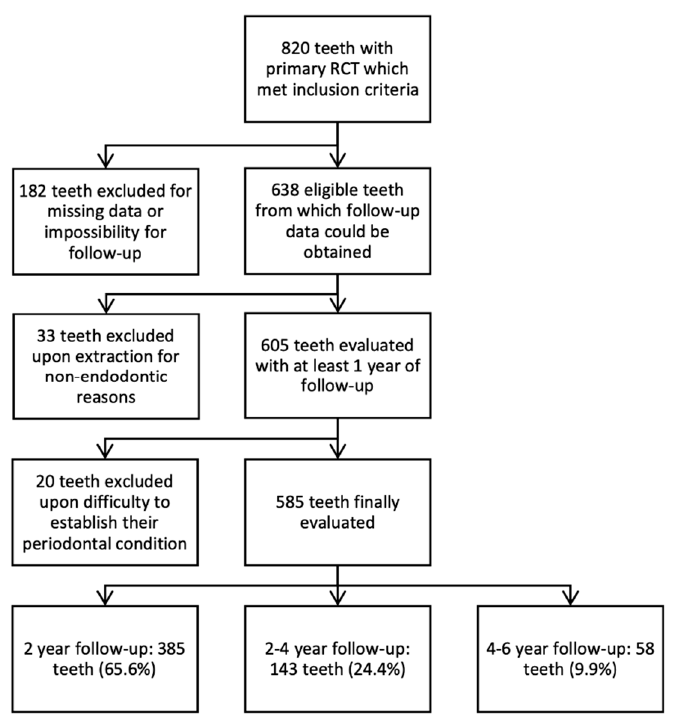
Figure 1. Flow diagram representing the follow-up of patients which met the inclusion criteria. Intra- and inter-observer agreement was assessed with regards to the radiographic evaluation. Intra-observer kappa values were 0.81 and 0.83, respectively, and the inter-observer kappa value was 0.82.